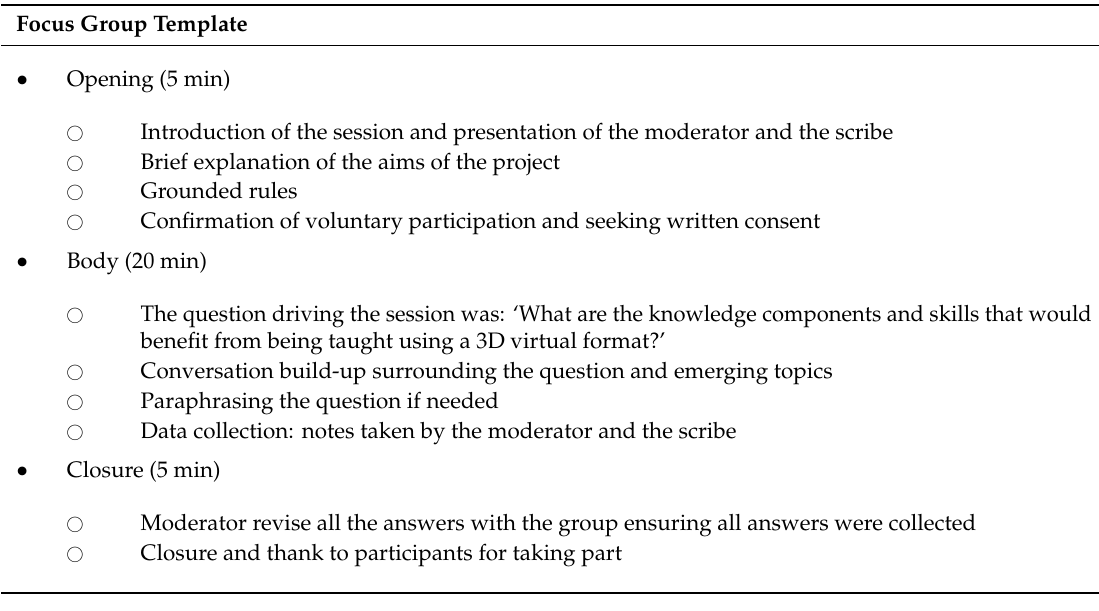
Table 1. Focus group